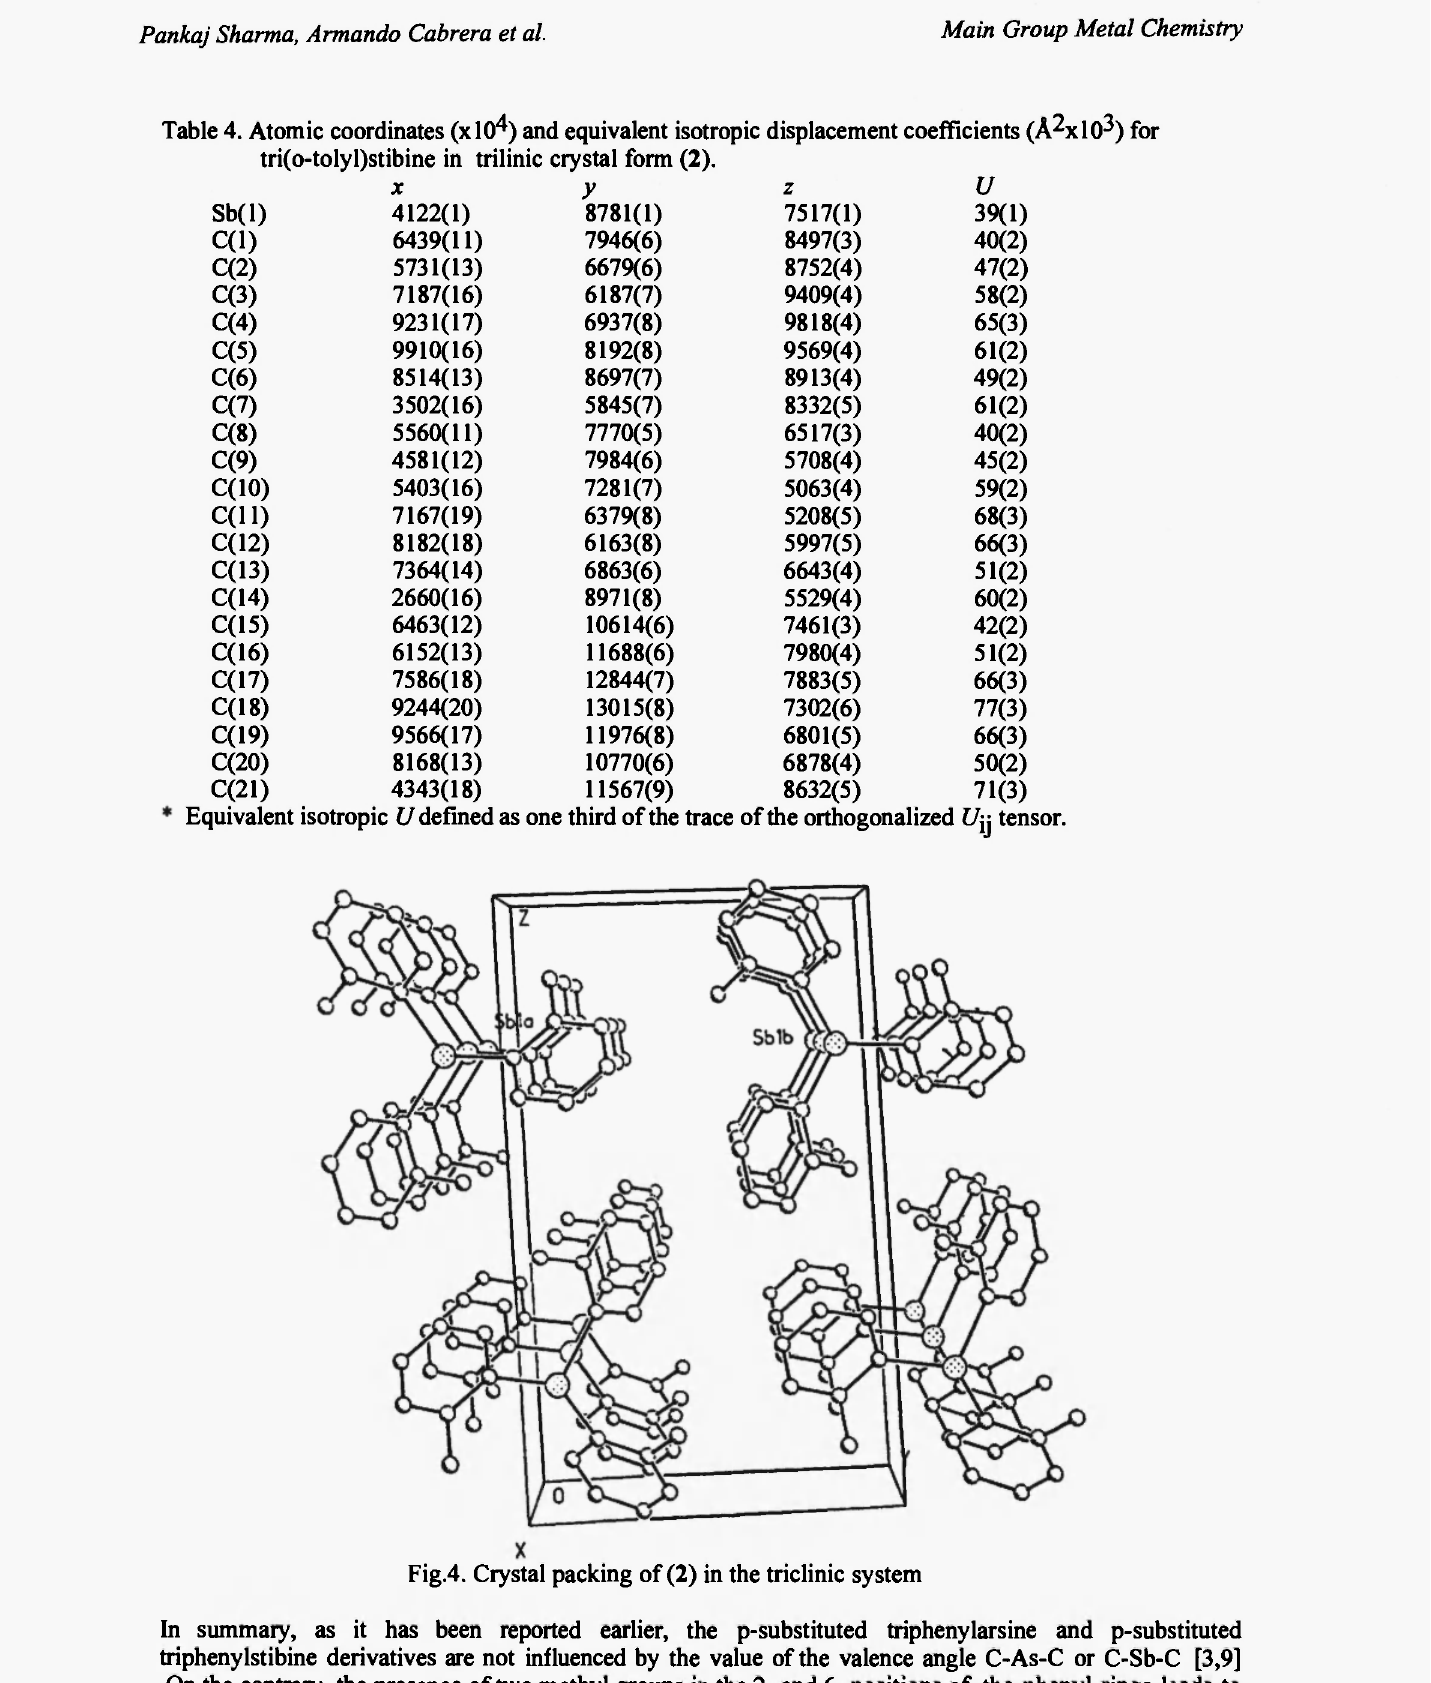
Fig.4. Crystal packing of (2) in the triclinic